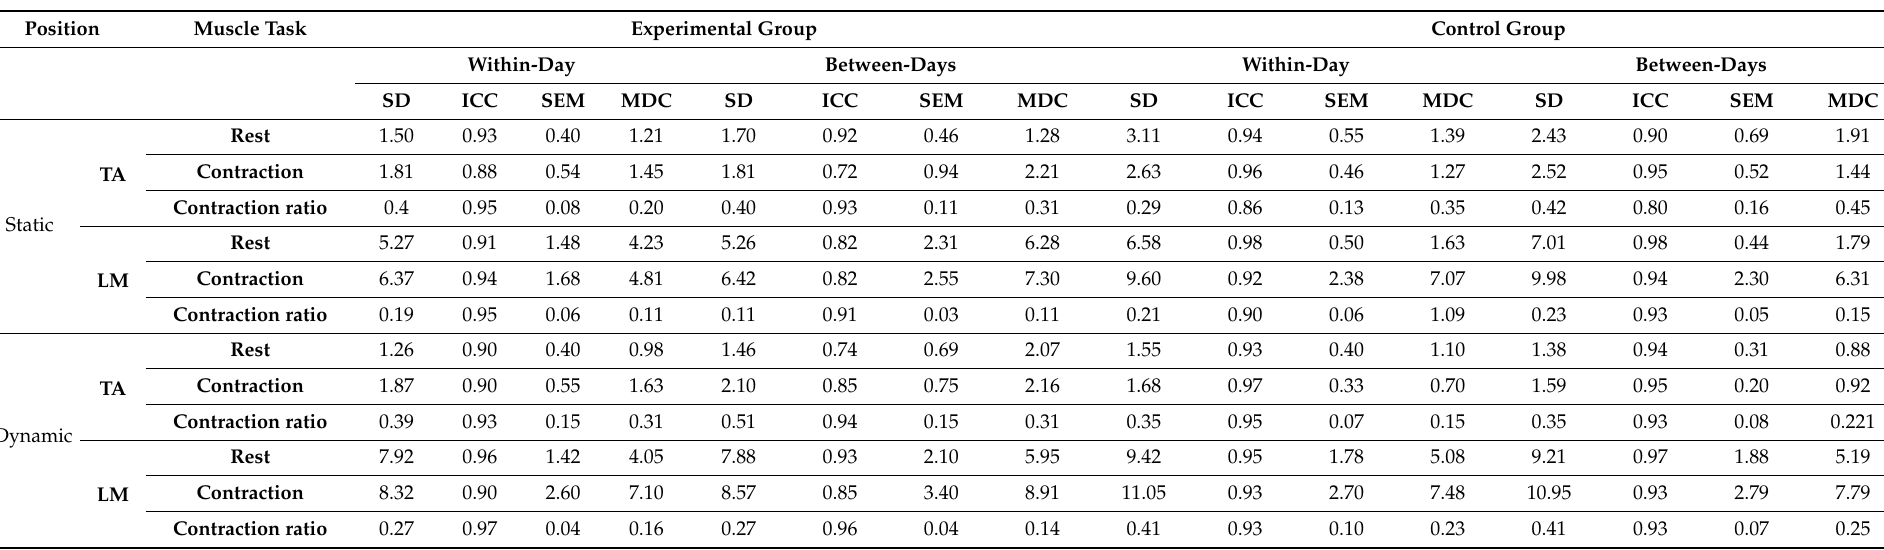
Table 2. SD, ICC, SEM and MDC values for within-day and between-days reliability of the ultrasound thickness measurements (in mm) and contraction ratio of the TA and LM muscles during different testing positions in both